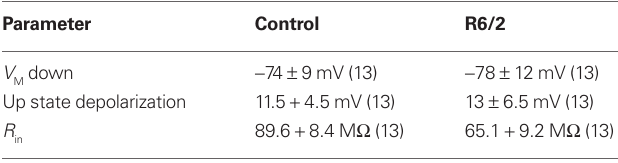
Table 1 | Membrane potential and input resistance properties of mouse neocortical neuronal membrane potential and input resistance.